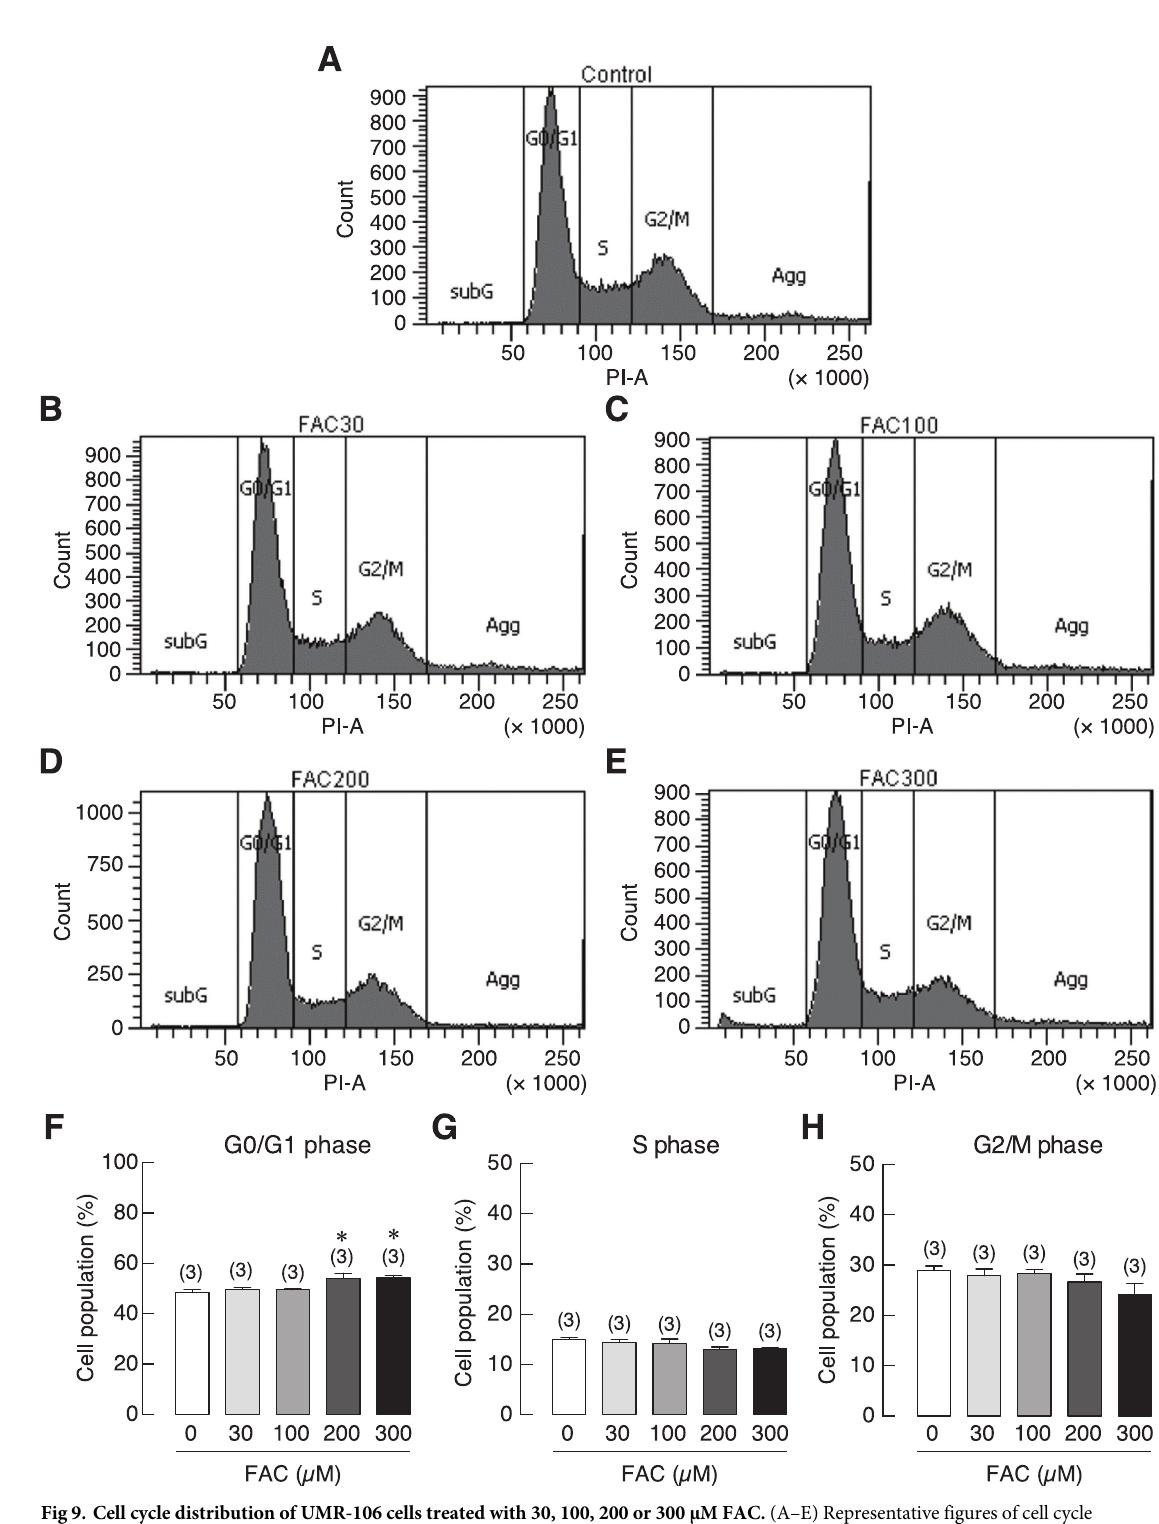
Fig 9. Cell cycle distribution of UMR-106 cells treated with 30, 100, 200 or 300 μ M FAC. (A–E) Representative figures of cell cycle distribution as determined by flow cytometry. Quantified data showing percent cell distribution in G0/G1 phases (F), S phase (G) and G2/M phases (H). � P < 0.05 as compared to control group (0 μ M); PI, propidium iodide.